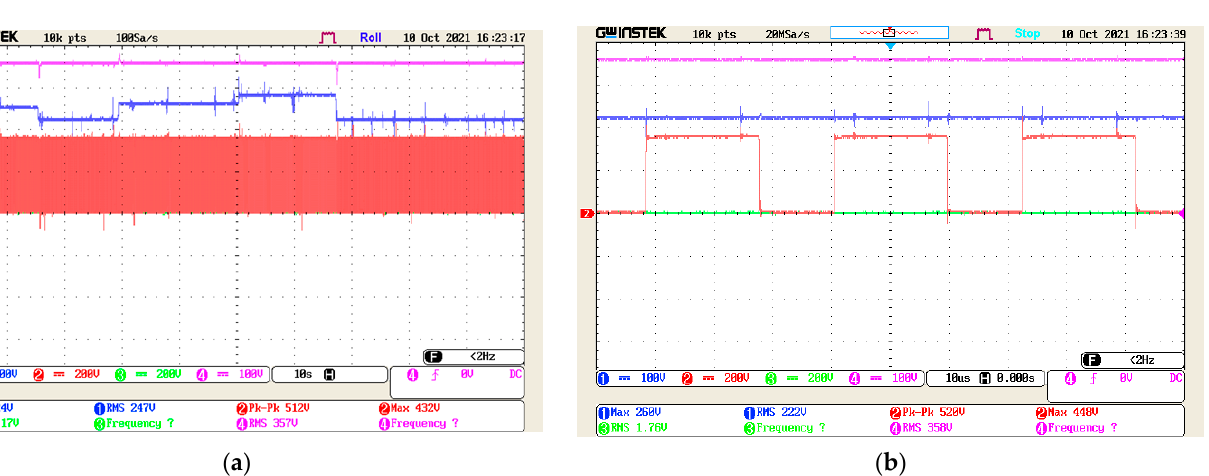
( b ) Figure 13. EKF MPPT test of two − phase IBC with 1 kW load: ( a ) partial shading and global MPPT tracking; ( b ) overall MPPT tracking efficiency. The implemented converter was then analyzed by increasing the solar plant power to 2 kW and loading it with resistive and lamp loads at 2 kW. As shown in Figure 14a, the V MP of the solar plant model has been set to 280.1 V and the Imp to 7.236 A. The solar plant was built with two parallel arrays of five series PV modules each. The analyzed operation demonstrated that the MPPT algorithm could track the GMPP with an MPPT efficiency of 96.50%. The overall converter efficiency of the proposed MPPT algorithm was 98.37%, as shown in Figure 14b, with the average power delivered to the load being 1936 W at the end of the test period.